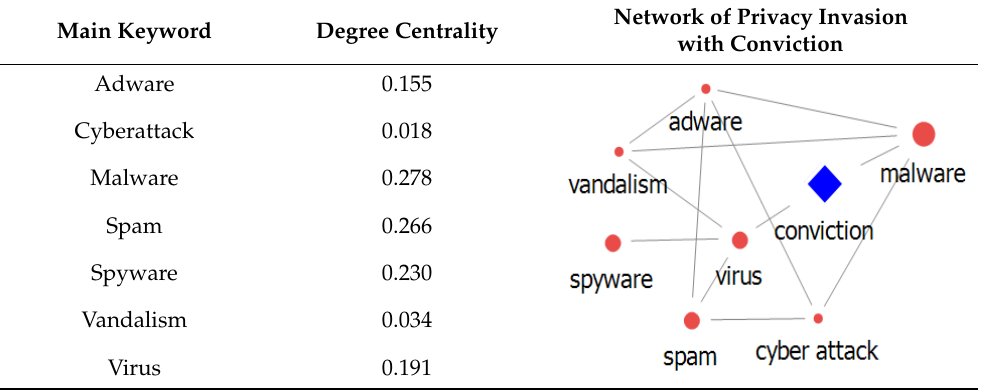
Table 6. Degree Centrality of